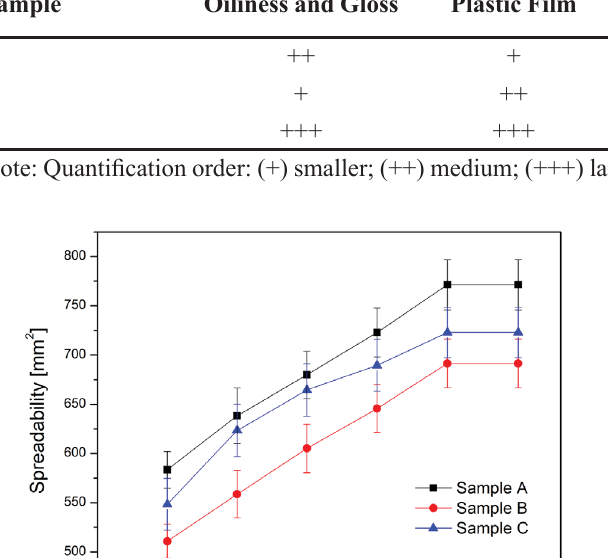
TABLE IV - Notes after applying masks to hair strands Sample